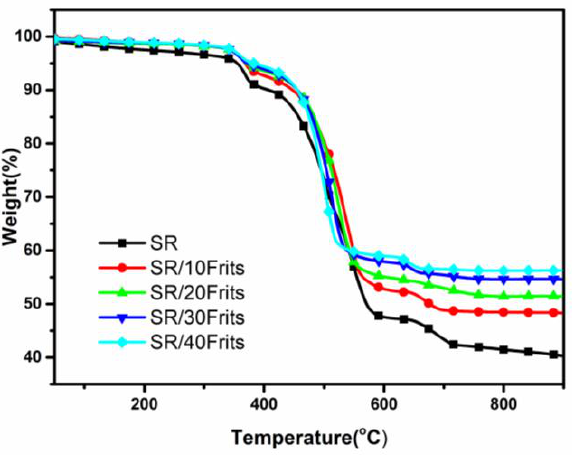
Figure 3. TG curves of SR/frit